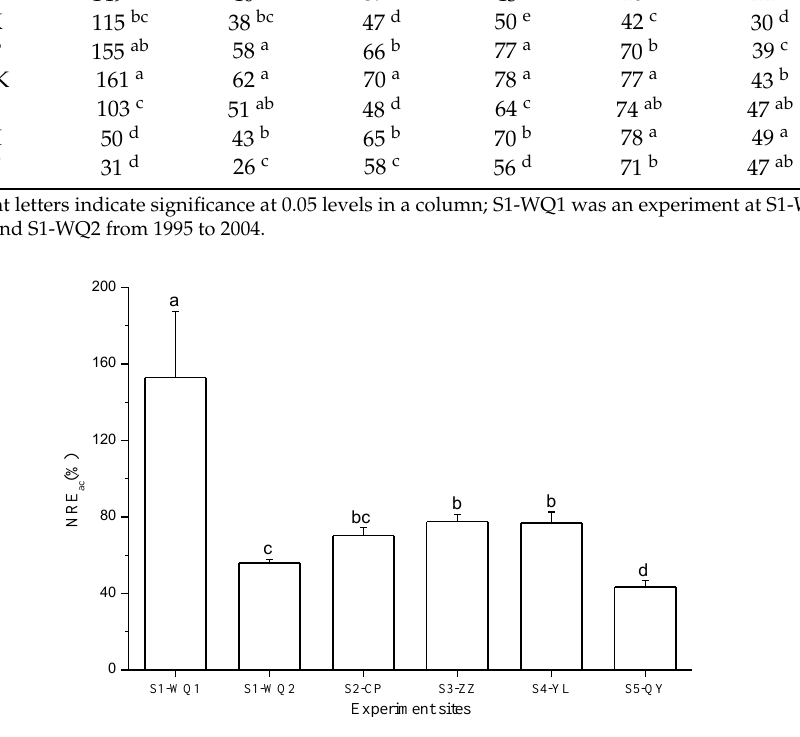
Figure 1. NRE ac from NPK in all sites. Note: Different letters indicate significant differences at 0.05